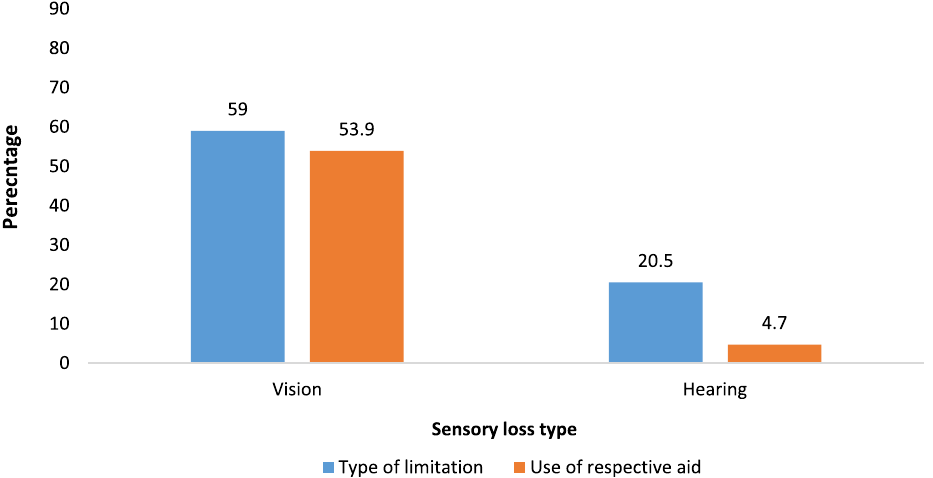
Figure 1. Percentage of older adults suffering from vision and hearing disability and their utilization of visual and hearing